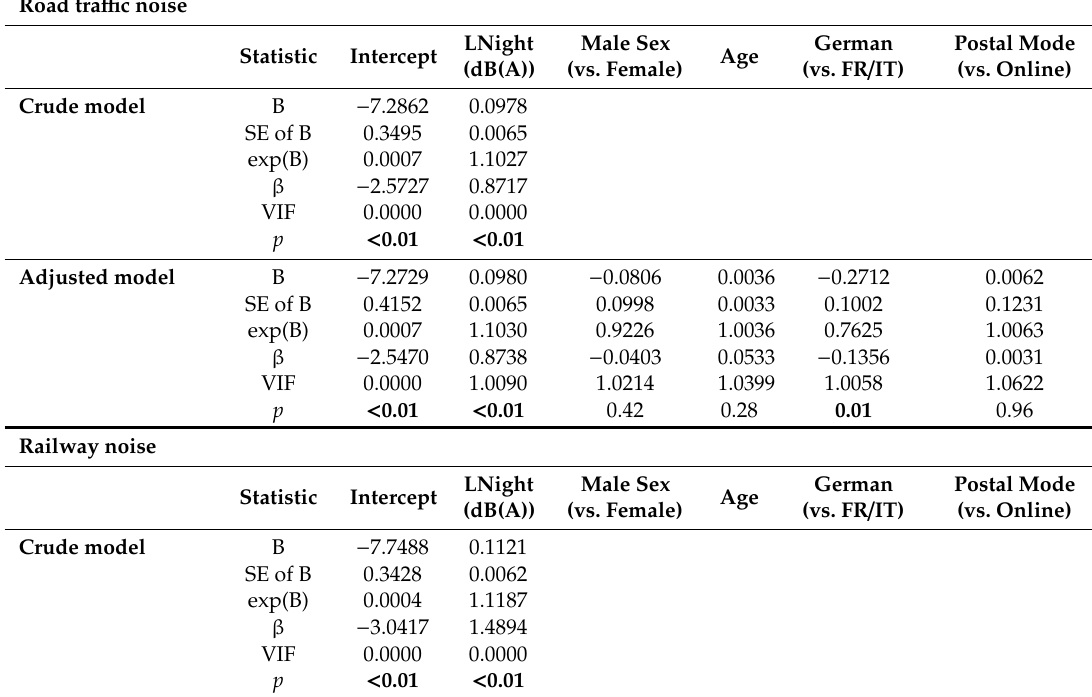
Table 3. Coe ffi cients of logistic regression models for the probability to be highly sleep disturbed (P HSD ), for road tra ffi c, railway, and aircraft noise LNight at the maximum façade point. The table lists unstandardized (B) and standardized ( β ) coe ffi cients, standard error of B (SE of B), odds ratios (exp(B) per 1 dB increase), and the variance inflation factor (VIF). Significant p -values are highlighted in